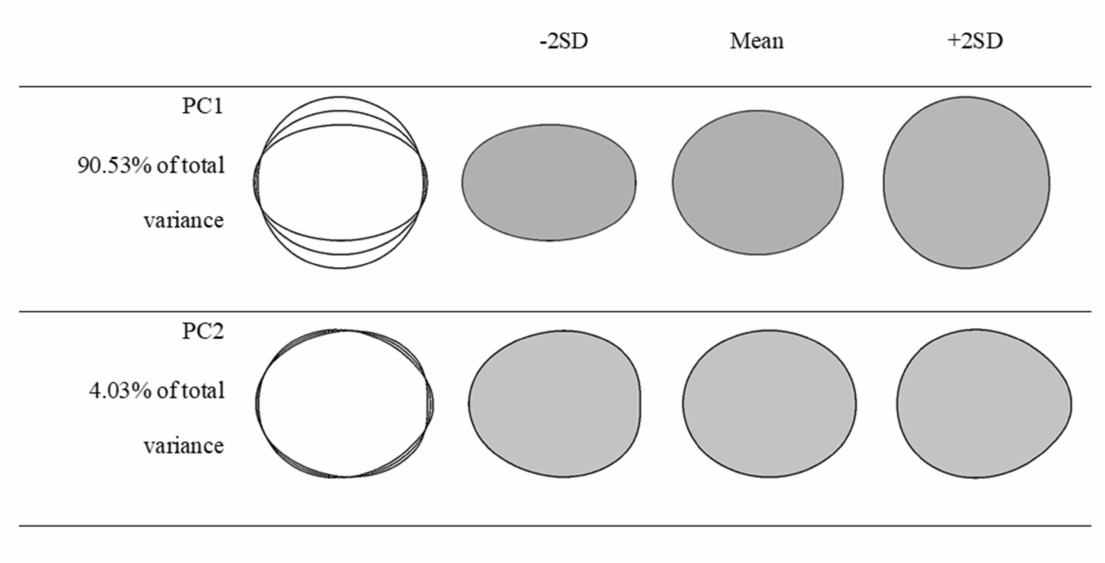
Figure 5. Principal components (PCs) as morphology variables of grape varieties based on a principal component analysis of 800 fruit outlines. From left to right, the outlines show the principal component scores corresponding to: mean − 2 standard deviations, mean, mean +2 standard